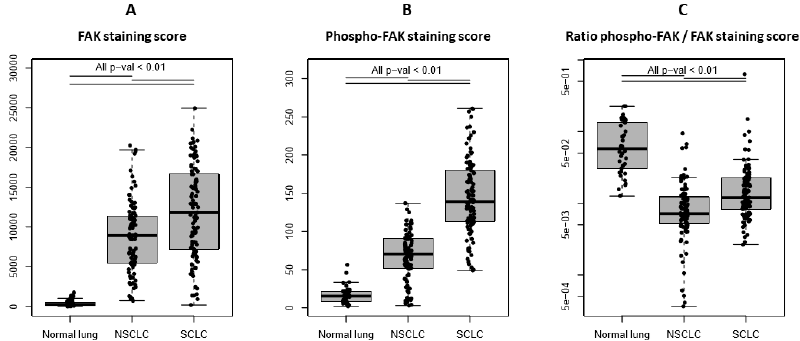
Figure 3. Quantification of FAK and phospho-FAK (Y397) expression evaluated by multiplex immunofluorescence immunohistochemistry in 37 normal lungs, 95 non-small-cell lung cancer (NSCLC), and 105 small-cell lung cancer (SCLC) tissues: ( A ) FAK staining score: Percentage (%) of FAK-stained tumor area multiplied by (x) FAK mean intensity, ( B ) phospho-FAK (Y397) staining score: (% of phospho-FAK-stained tumor area of low intensity × 1) + (% of phospho-FAK-stained tumor area of medium intensity × 2) + (% of phospho-FAK-stained tumor area of high intensity × 3), and ( C ) ratio between phospho-FAK and FAK staining scores. Each dot represents one sample. Data presented as the mean ± S.D. p -values were obtained using linear models and adjusted for multiple testing using the Bonferroni method.